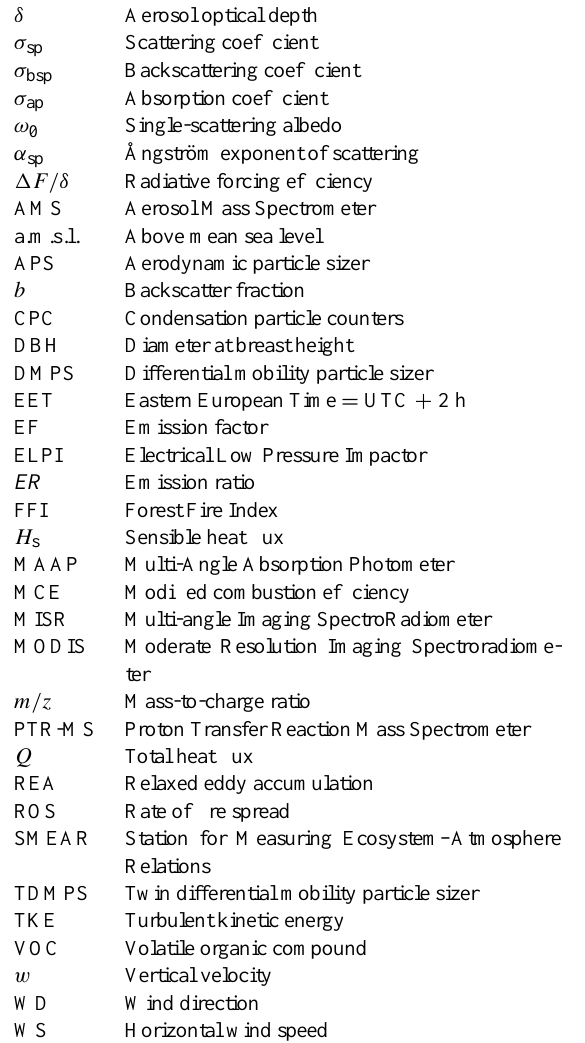
Table A1. Acronyms and